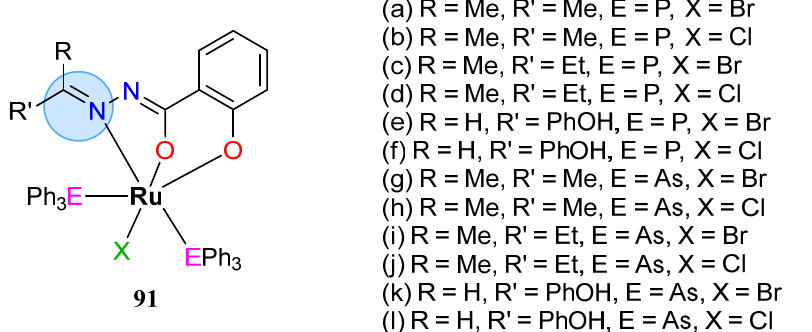
Figure 48. Ruthenium(III) complexes with tridentate Schiff base ligands (ONO) derived from salicyloyl hydrazide with antibacterial activity.